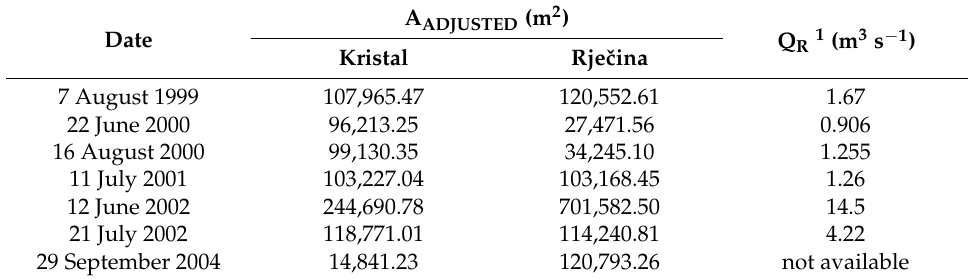
Figure 3. Example of estimating maximum SST for both locations on 12 June 2002: SST MAX (Kristal) = 295.95 K ( a ); SST MAX (Rjeˇcina) = 295.19 K ( b ). Table 4. Adjusted area of influence and corresponding discharges measured in Rjeˇcina Table 3. Minimum and maximum SST at the outlet locations.